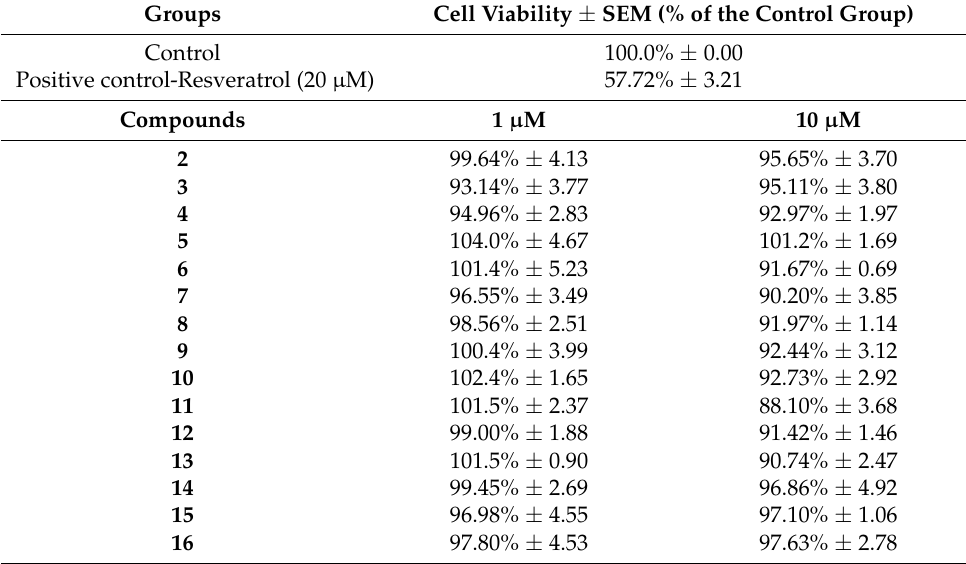
Table 3. Cytotoxicity of compounds on BV2